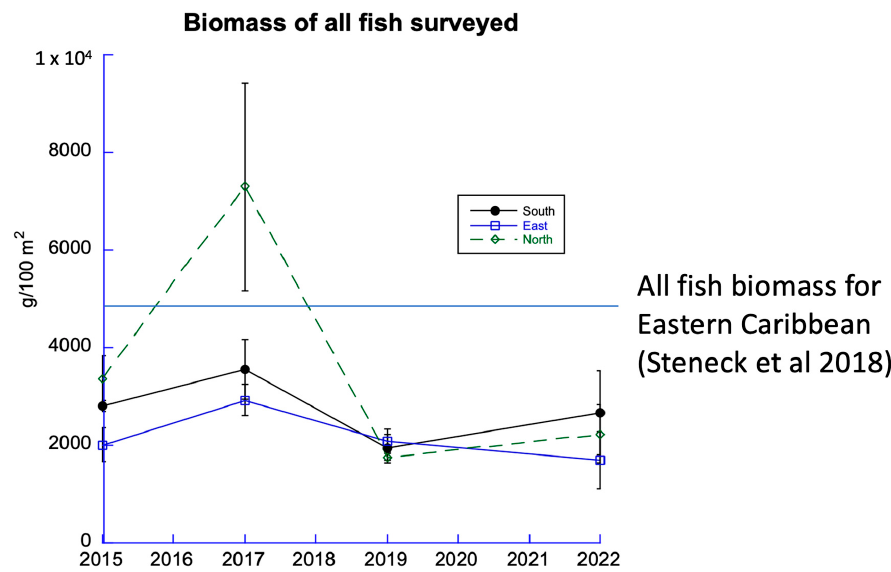
Figure 7. Biomass of all fish from all transects, 2015 to 2022. The horizontal line illustrates the biomass of all fish surveyed for the Eastern Caribbean [6].